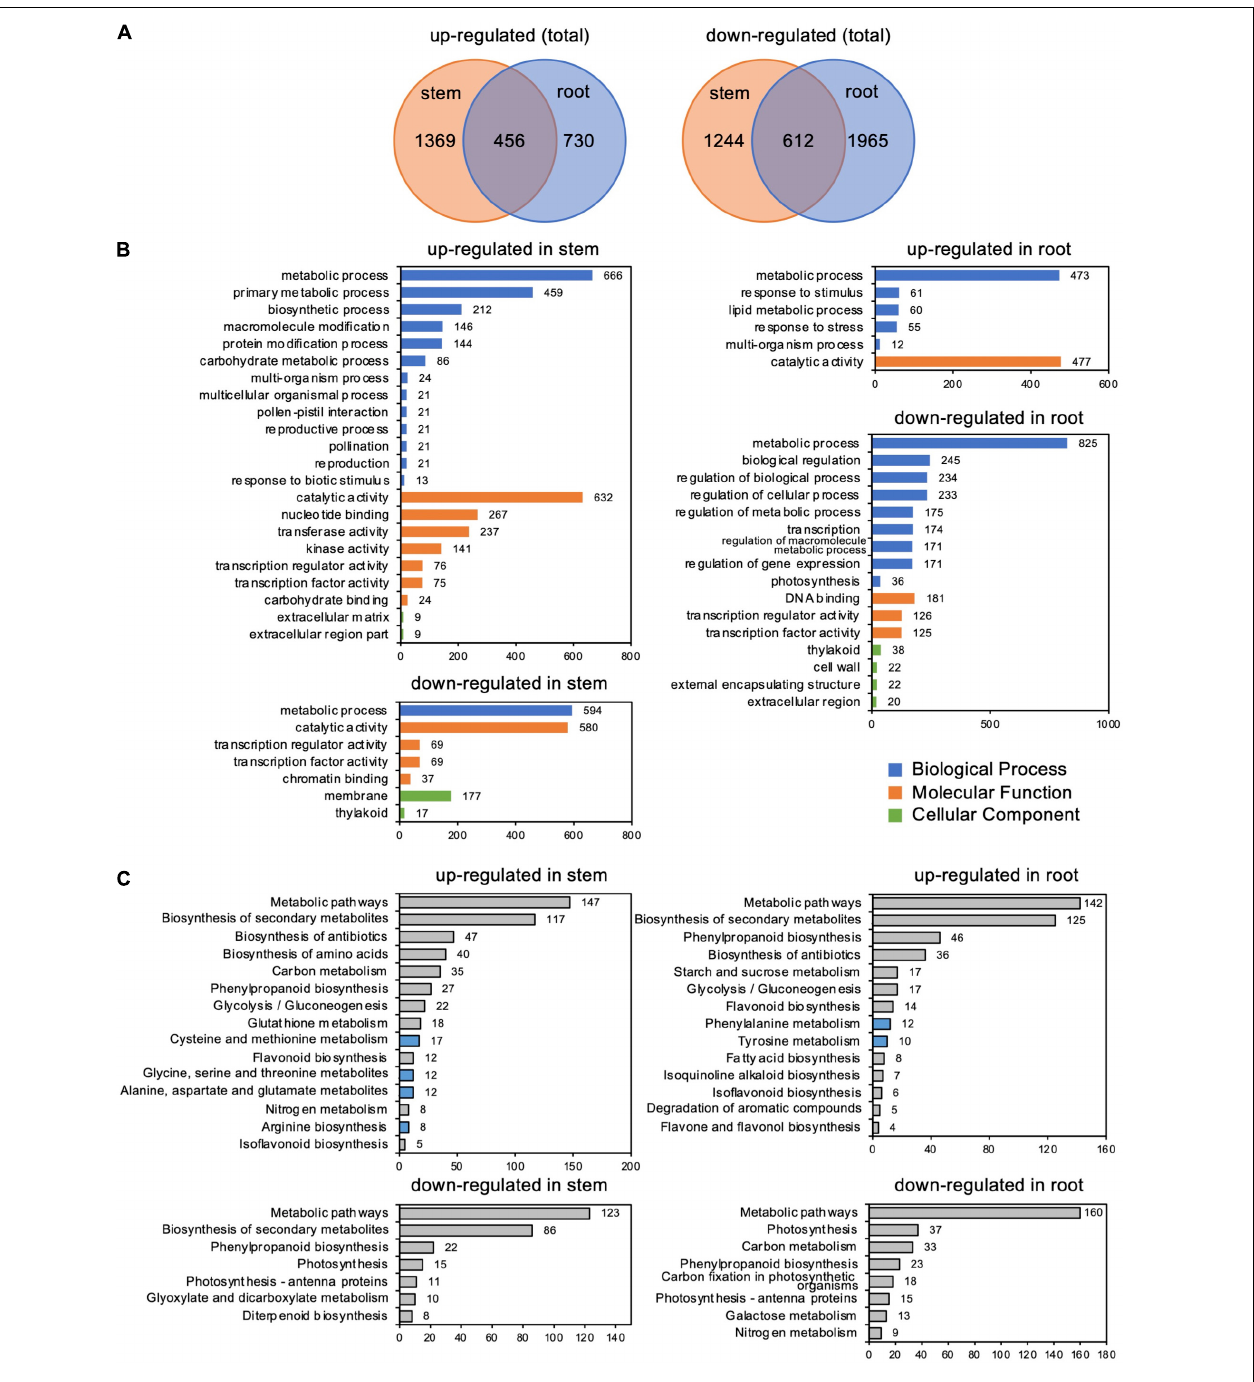
FIGURE 5 | Differentially expressed genes (DEGs) in stems and roots inoculated with Calonectria ilicicola at 24 h post-inoculation (hpi). (A) Venn diagram showing the number of significant DEGs (FDR < 0.05, > twofold) and shared genes in stems and roots. (B) GO term enrichment analysis of identified DEGs. The horizontal axis shows the number of genes classified into each GO term. (C) KEGG pathway enrichment analysis of identified